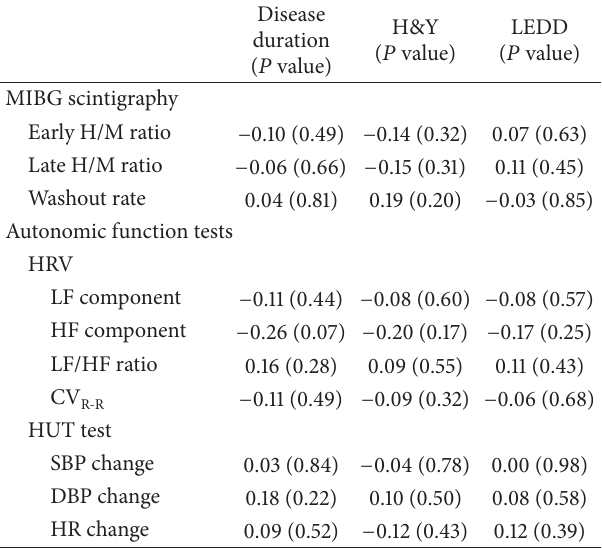
Table 1: Correlation between disease parameters and MIBG scintig- raphy or autonomic function tests.